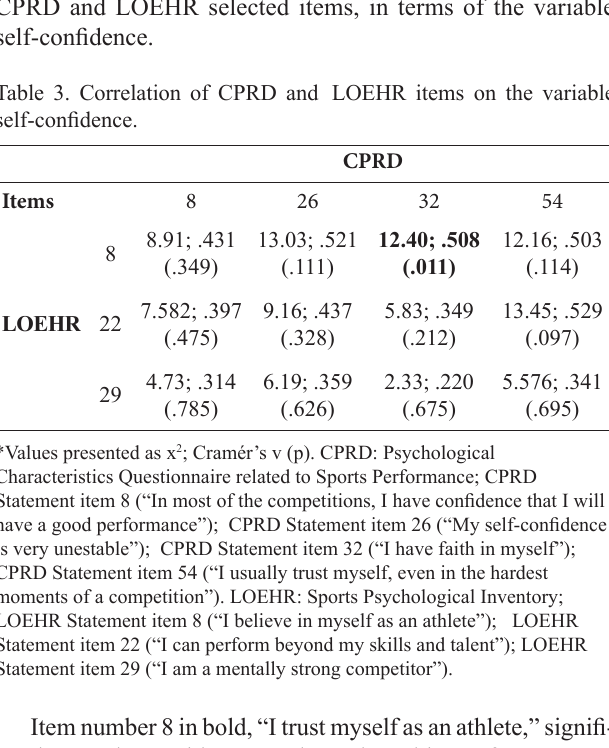
Table 5. CPRD, CSAI-2 and LOEHR selected items for the correla- tional study of anxiety.